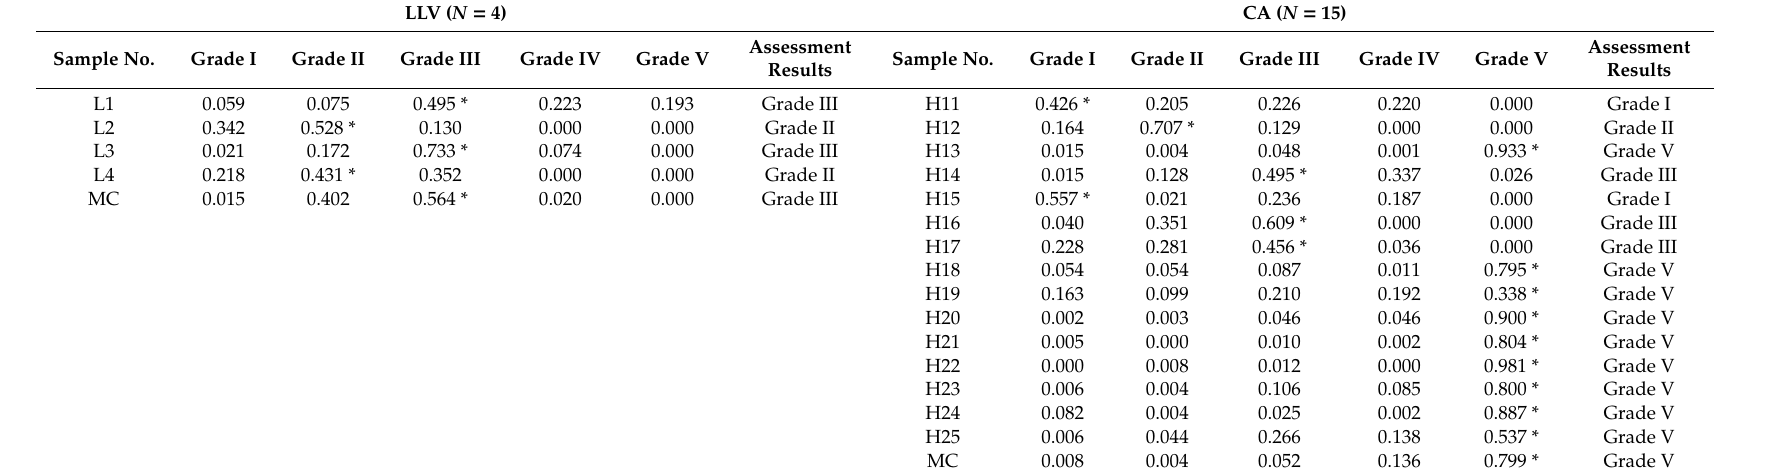
Table 7. Comparative assessment result of water environment quality based on